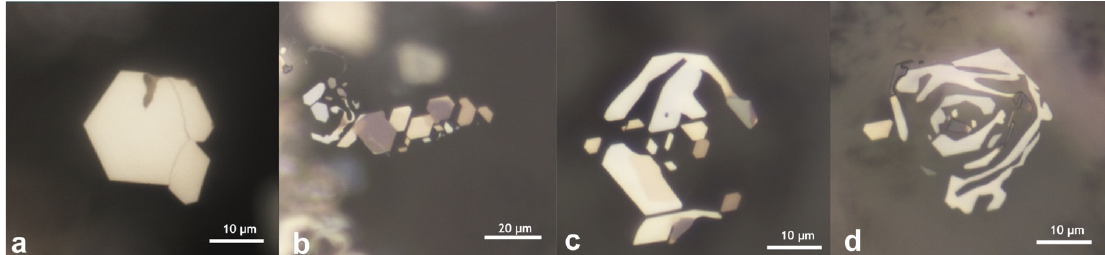
Figure 6. The metallic minerals were observed under microscopic observation, Mag: magnetite, Hem: hematite.